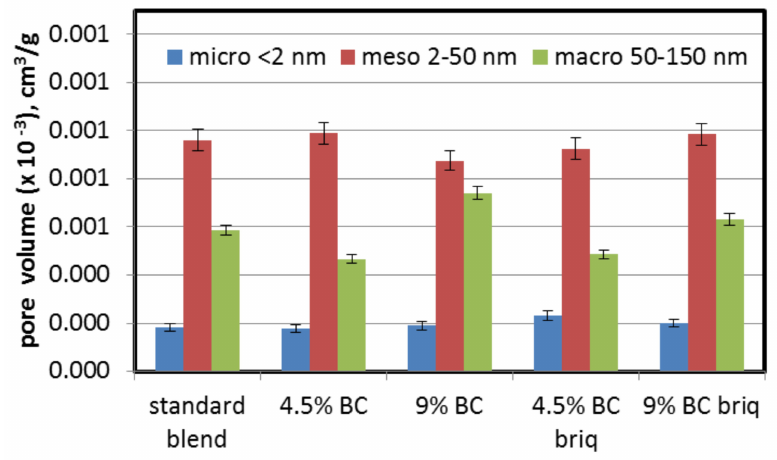
Figure 6. Influence of lignite addition on volume of pores measured via N 2